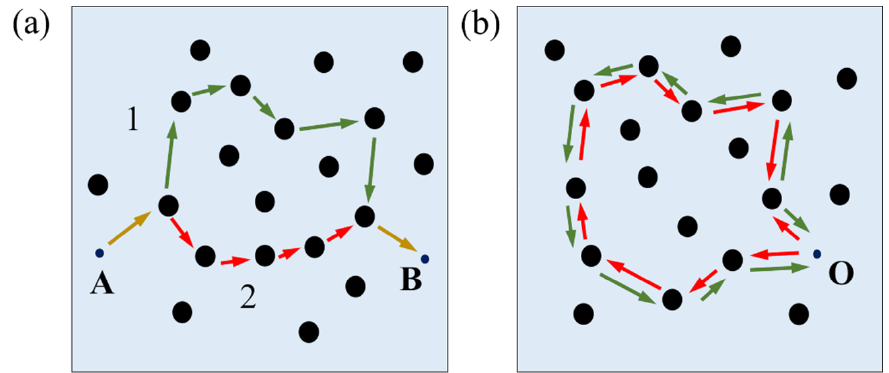
Figure 4. Sketch representing the movement of electrons through scattering centers: ( a ) two possible paths (1 and 2) for an electron going from A to B. ( b ) A loop formed by time reversal partners. In materials with strong spin–orbit interaction, the spin orientation is not